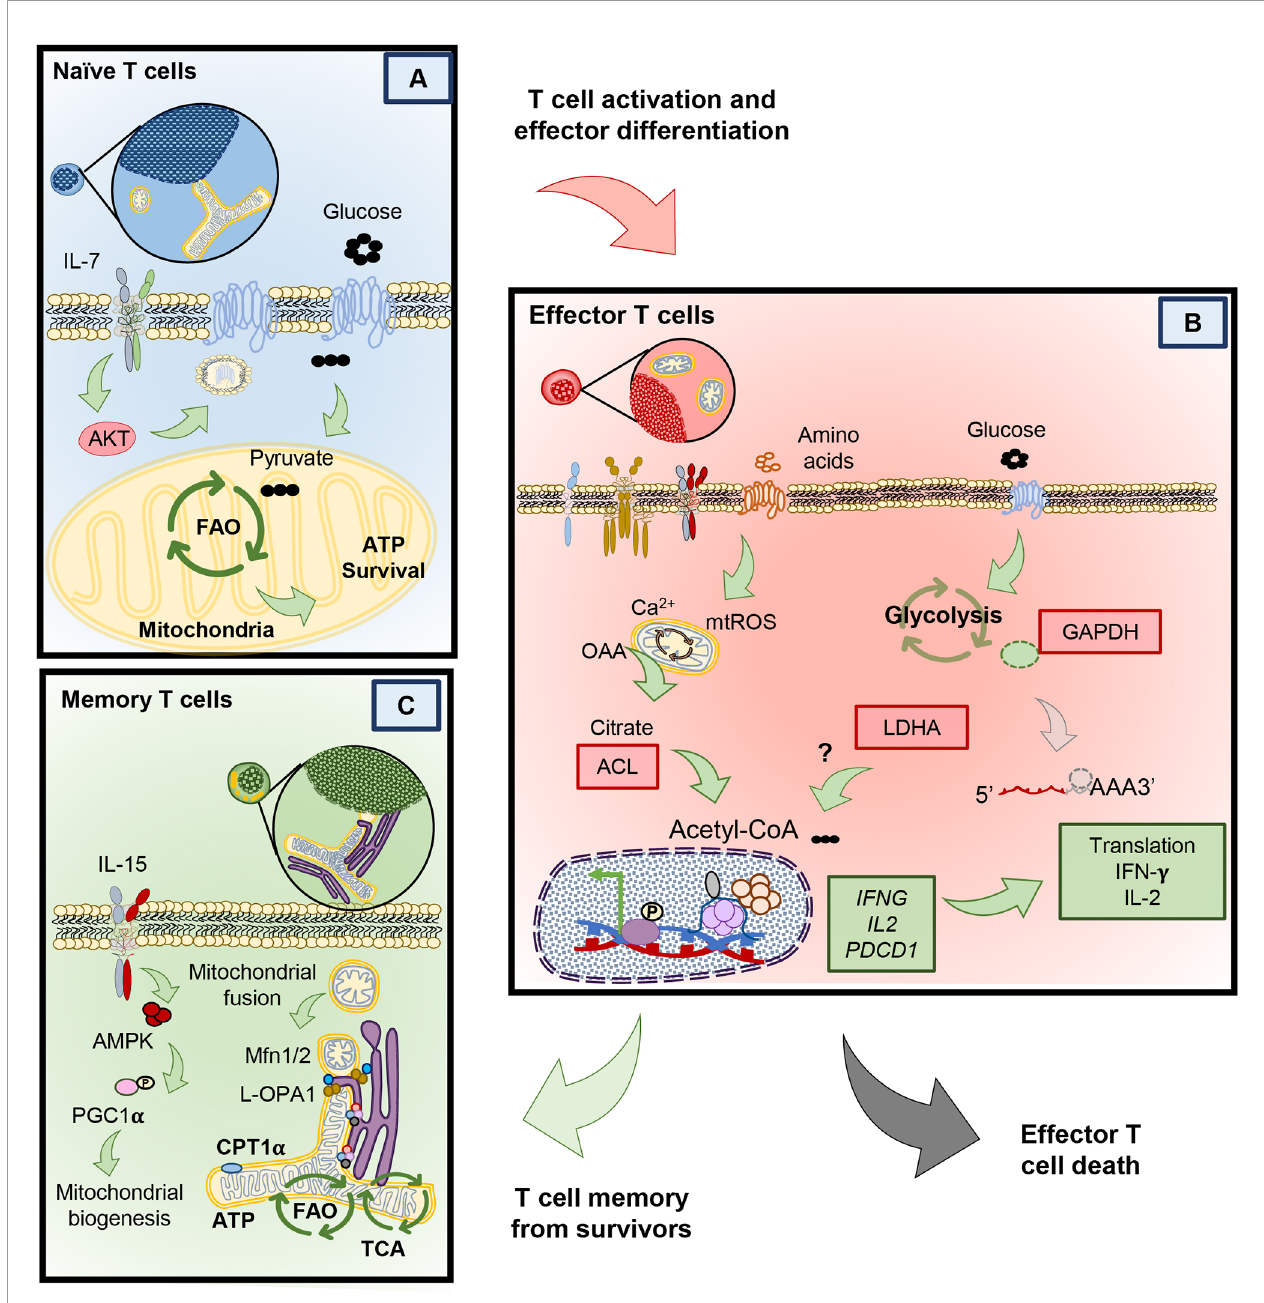
FIGURE 2 | Different metabolic programs between naïve, memory and effector T cells. (A) Naïve T cells rely on the full oxidation of glucose through OXPHOS, in the absence of TCR stimulation. (B) Upon T cell stimulation T cells undergo protein and transcriptional changes in metabolism that allow the sustained activity of glycolysis and other amino acid uptake and usage. Glycolysis by products in effector T cells mediate changes that help sustain effector cytokine release and cytolytic function. Effector T cells that clear antigen either die or contract to form memory T cells. (C) Compared to effectors, memory T cells possess an enhanced metabolic pro fi le dependent on mitochondrial biogenesis, mitochondrial fusion and reliance on fatty acid